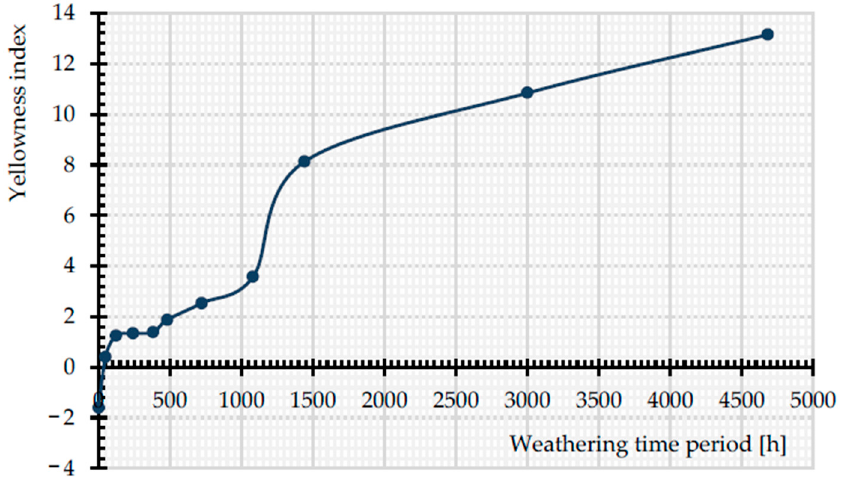
Figure 18. Change in YI with exposure time, from 0 to 4684 h, uncoated PET Type II.